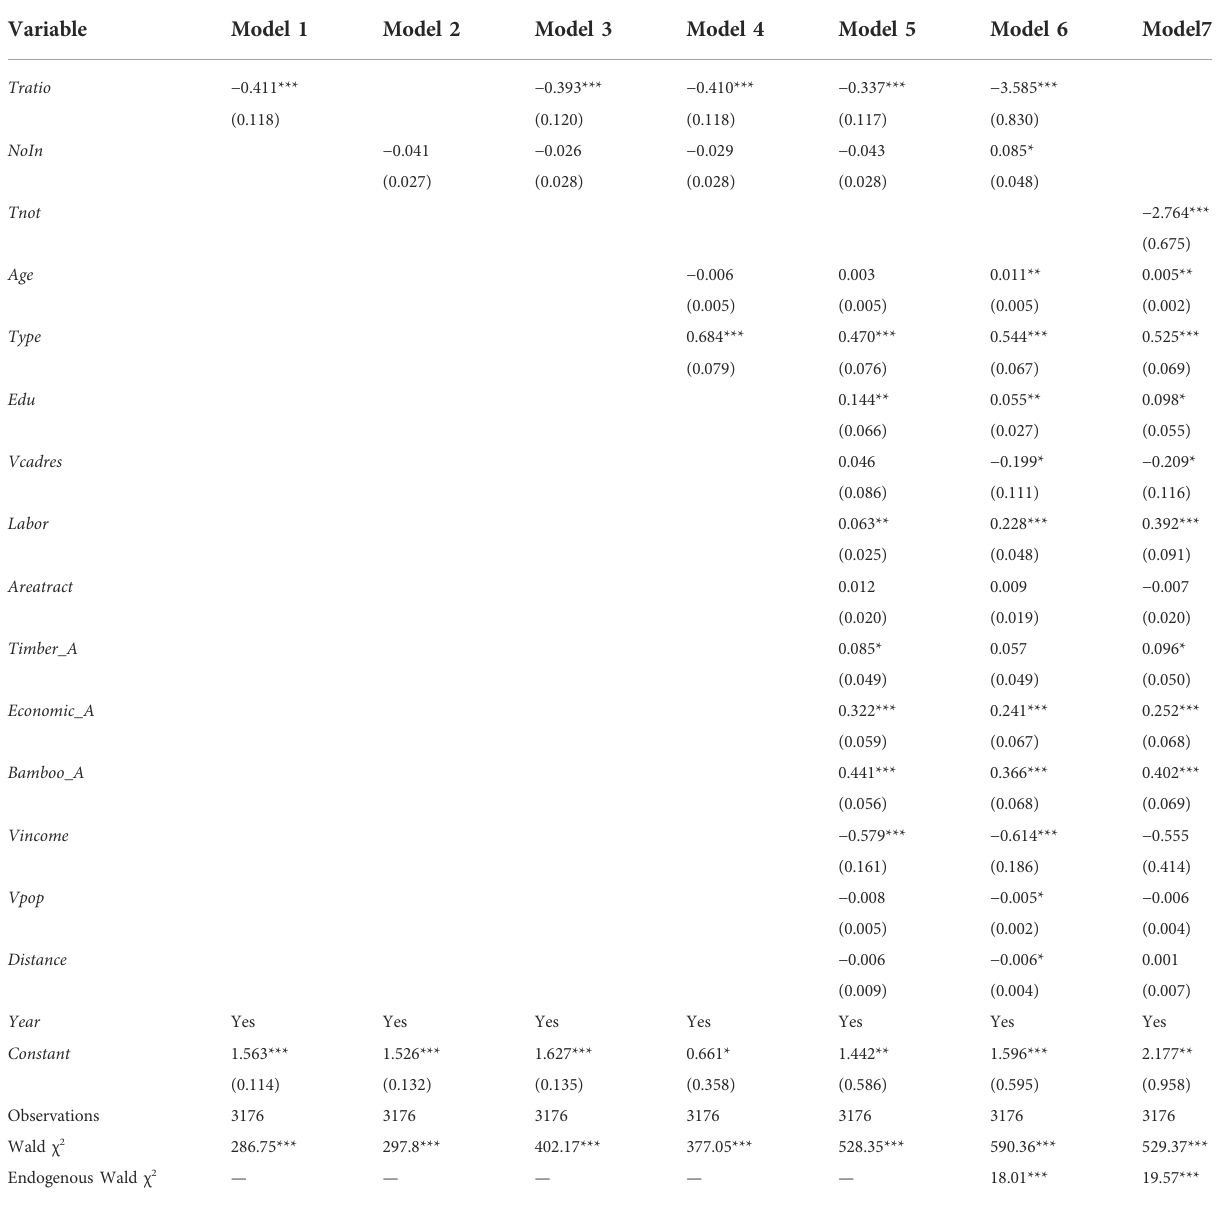
TABLE 2 Results of benchmark regression of labor migration on forest management income.